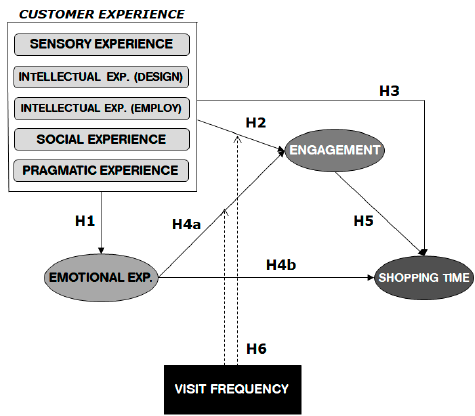
Figure 1. Conceptual model exploring customer experience, engagement, and shopping time.